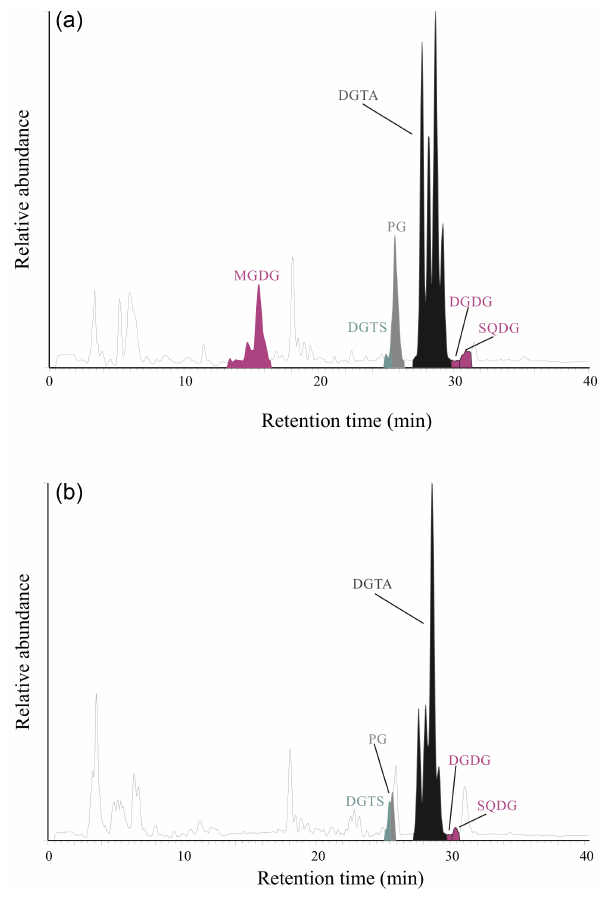
Figure 2. Partial base peak chromatogram (MS1, m/z 400–2000) of lipid extract of M. pusilla (a) and the virus MpV-08T (b) obtained by HPLC-MS analysis.